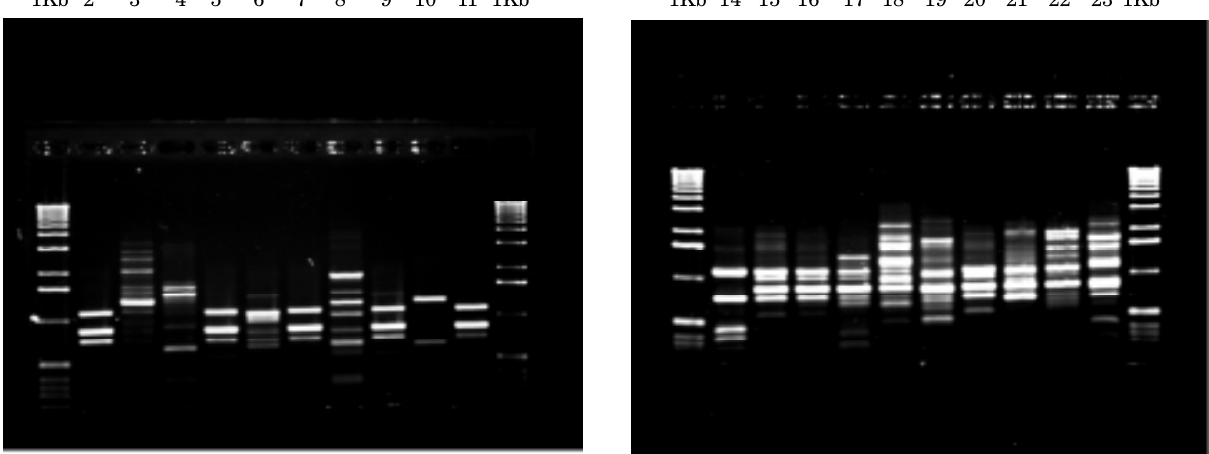
Fig. 1. Example of Random amplified polymorphic patterns of genomic DNA amplified with primer UBC 83 from 20 Verticillium dahliae isolates. Lane 2, R21; lane 3, D2; lane 4, 225; lane 5, 147; lane 6, VS; lane 7, 81; lane 8, V72; lane 9, 44; lane 10, B32; lane 11, 94; lane 14, V62; lane 15, AT16; lane 16, Ar4; lane 17, AT32; lane 18, S33; lane 19, F;